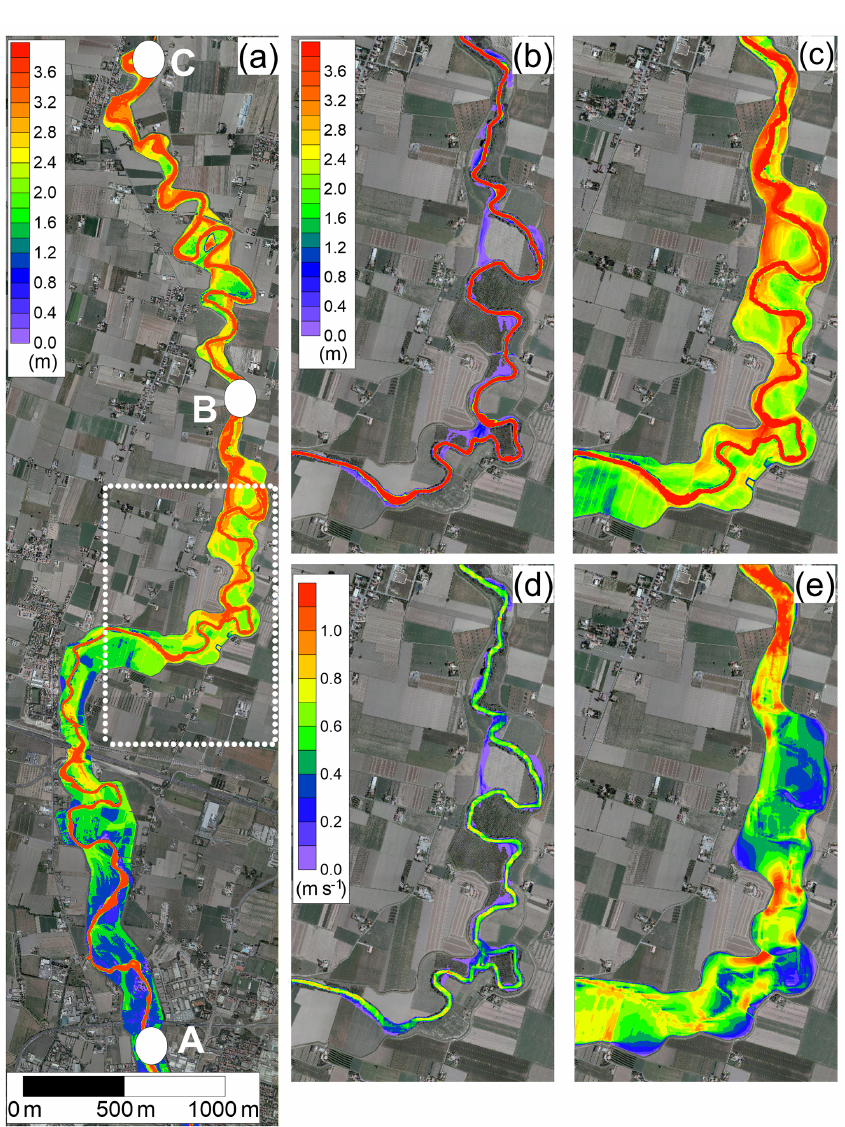
Figure 7. Map of the maximum simulated water depths for the Parma River. (a) the upstream (A) and downstream (C) boundary conditions and the intermediate observation site (B) are indicated. With reference to the area marked with dotted white line in (a) , (b) and (c) represent the water depths and (d) and (e) the velocity field at low and high discharge values,